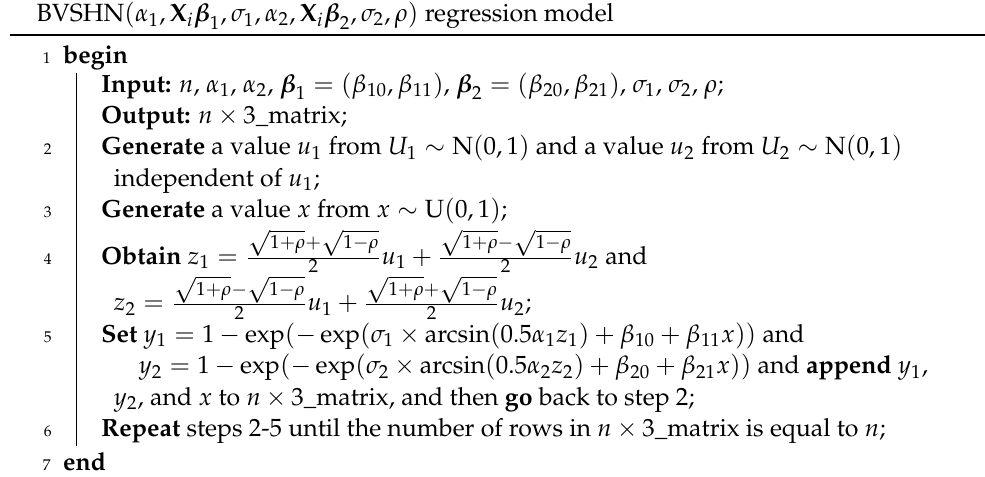
Algorithm 1: Algorithm to generate a random sample from